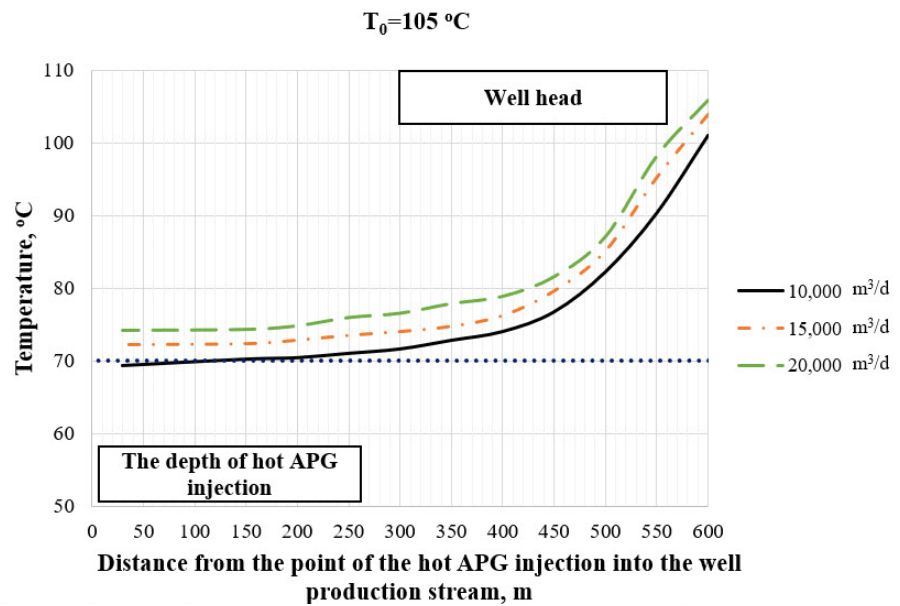
Figure 8. Annulus hot APG temperature profile, inlet T 0 = 105 °C.